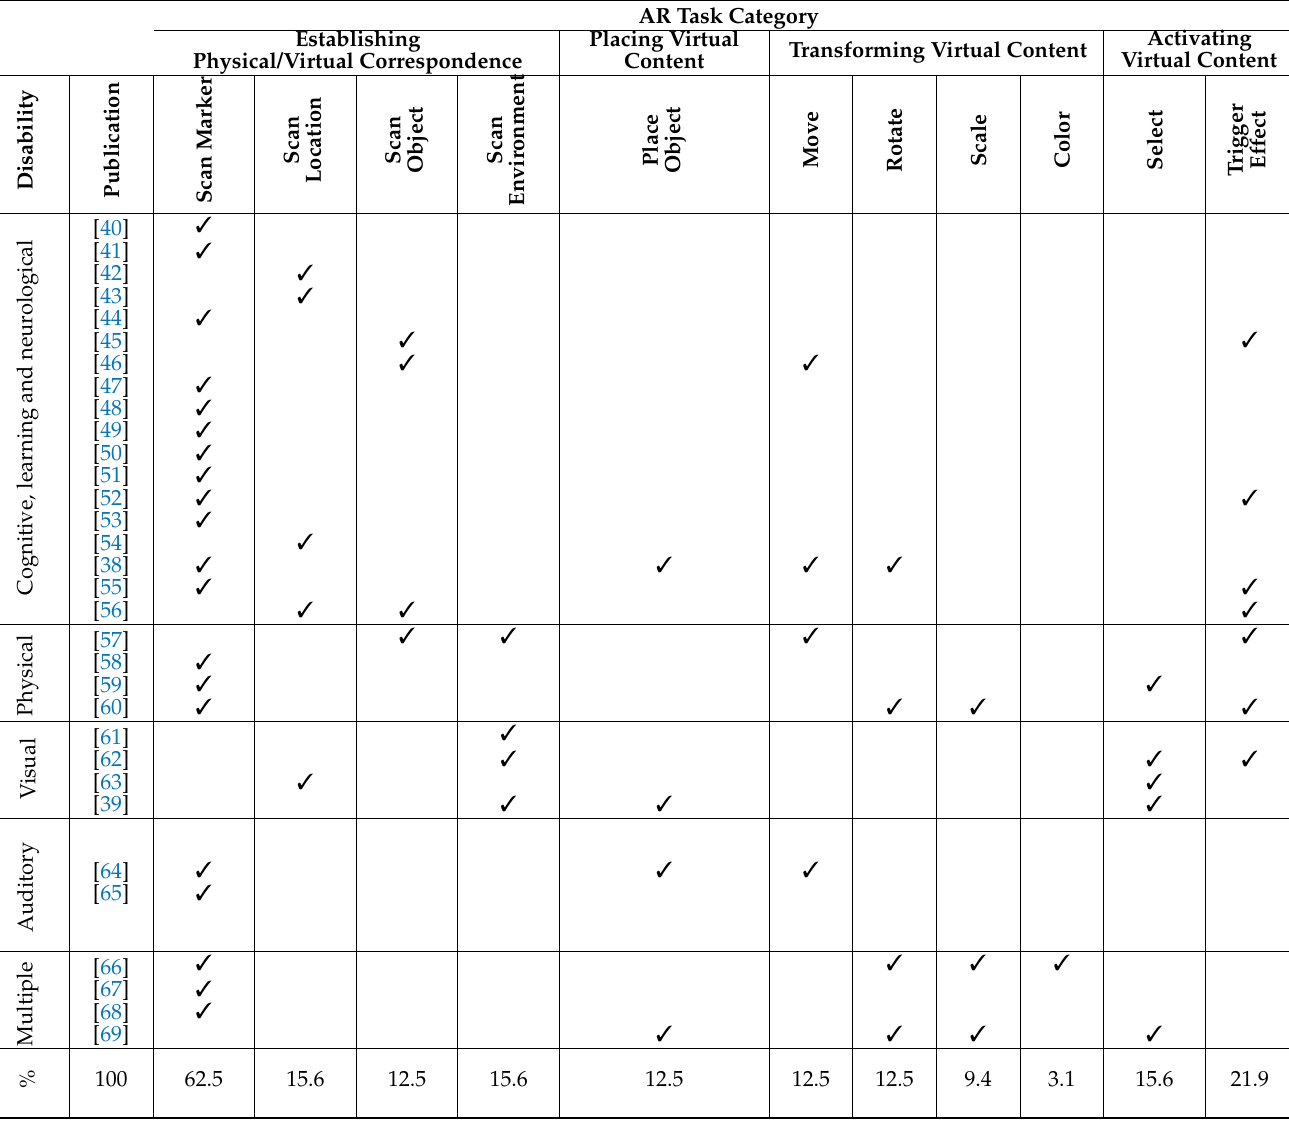
Table 2. Identified task types in every publication categorized by task category and disability type. AR Task Category